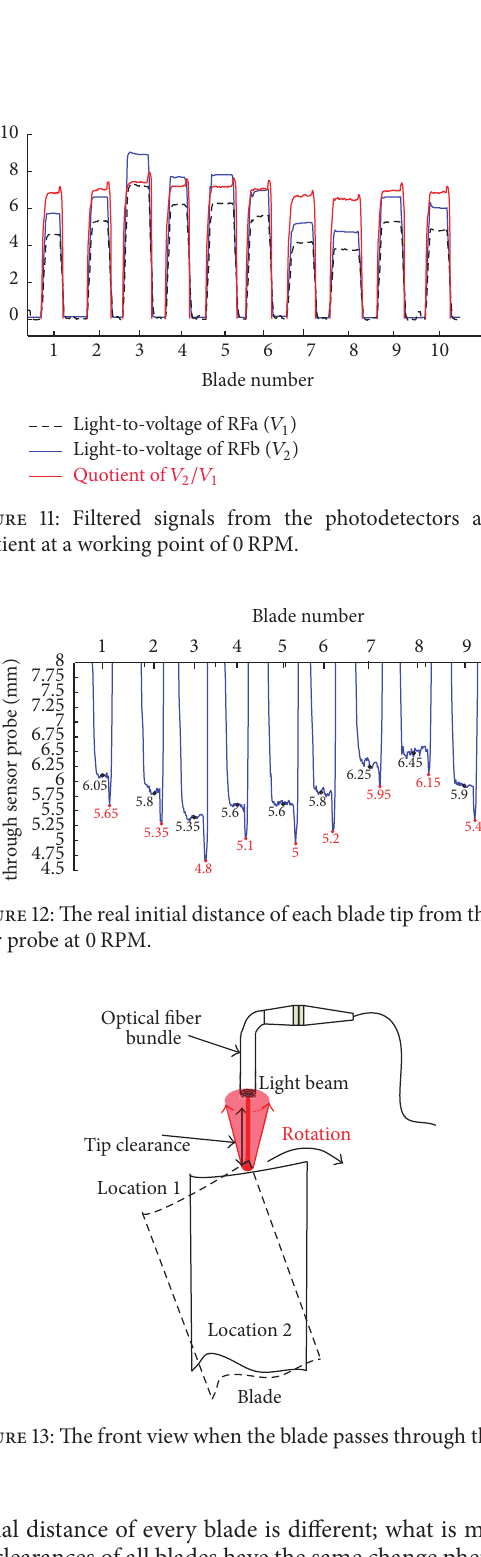
initial distance of every blade is different; what is more, the tip clearances of all blades have the same change phenomena when the blade passes through the front of the optical fiber probe. This can be explained by the blade tip surface with a small tilt angle; the geometry relationship of blade tip via the probe was shown in Figure